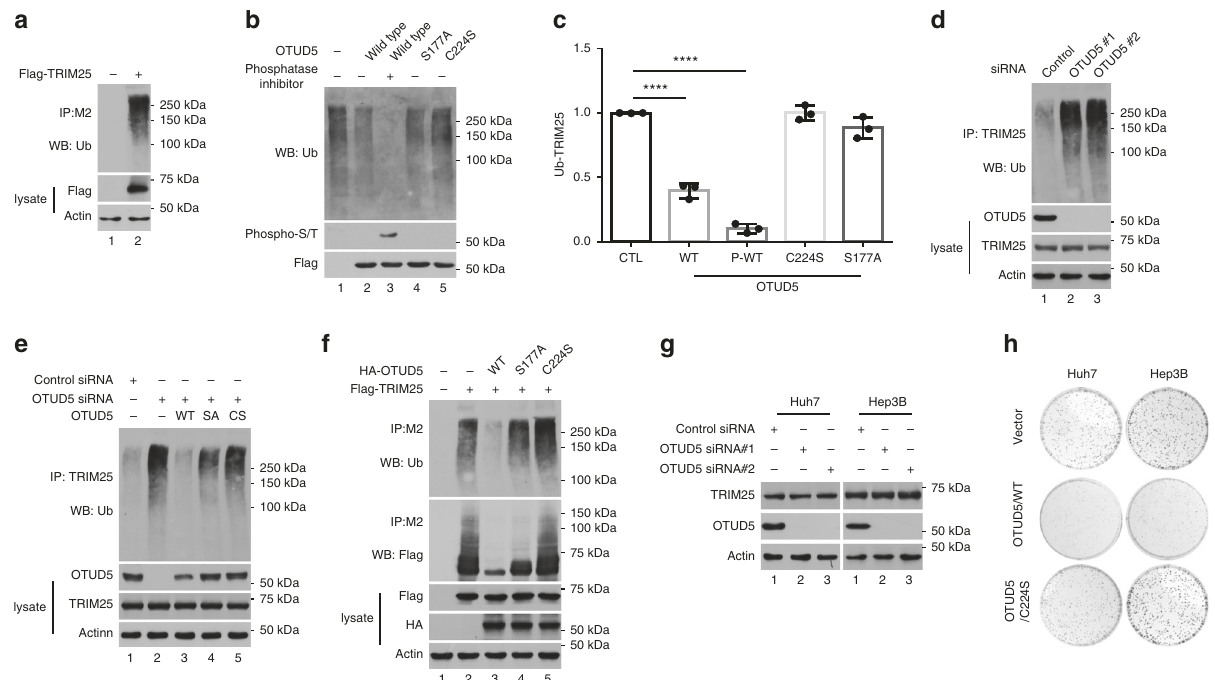
Fig. 3 OTUD5 deubiquitinated TRIM25. a TRIM25 was highly autoubiquitinated. b The in vitro deubiquitination assay using puri fi ed OTUD5 and TRIM25- ubs. OTUD5/WT, OTUD5/C224S or OTUD5/S177A was respectively incubated with TRIM25-ubs for the in vitro assay. c The in vitro deubiquitination assay performed in b was repeated three times. The signal intensity of the TRIM25-ubs was measured by Image-Lab software (Version 3.0 beta). Data are represented as means ± SD from three biological experiments. **** p < 0.0001 (CTL versus WT), **** p < 0.0001 (CTL versus p-WT), two-tailed unpaired t - test. p, phosphorylation. d The level of ubiquitinated TRIM25 increased following OTUD5 depletion by siRNA in the Hep3B cells. e Complementation with OTUD5/WT, but not with the catalytically inactive OTUD5 mutant, reduced the level of ubiquitinated TRIM25. f Co-overexpressing OTUD5/WT but not OTUD5/S177A or OTUD5/C224S reduced the level of ubiquitinated TRIM25. g Depletion of OTUD5 did not affect the level of TRIM25 protein. h The catalytic activity of OTUD5 was crucial for its function in the regulation of cell proliferation. Source data are provided as a Source Data fi